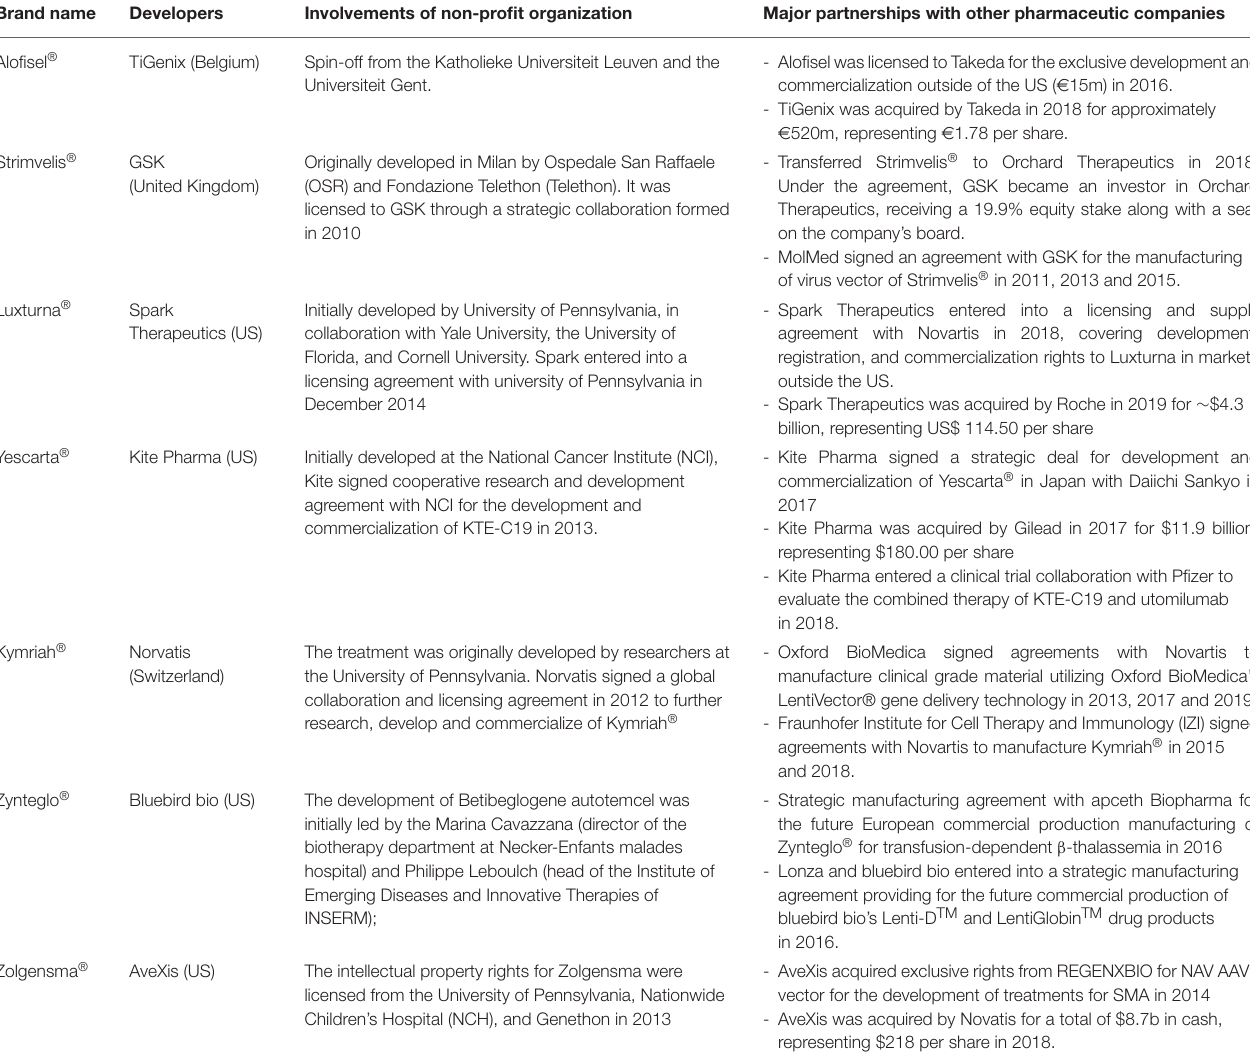
TABLE 1 | The collaborative mechanisms for ATMPs on the Europe